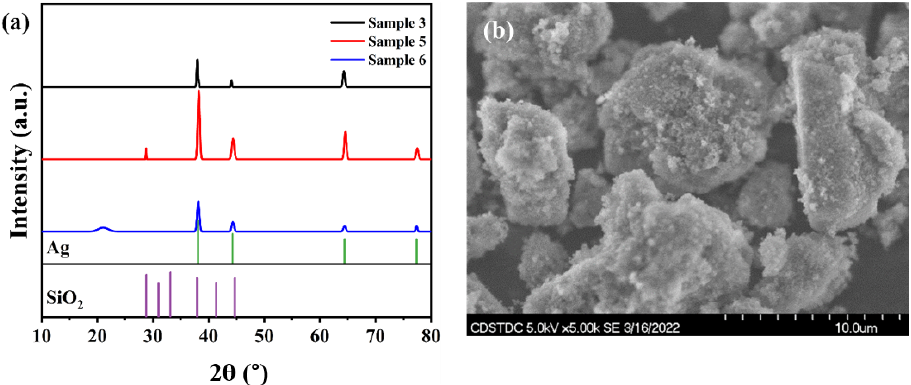
Figure 2. XRD patterns of modified samples 3, 5, and 6 ( a ), SEM diagram of SiO 2 @Ag core-shell particle ( b ).